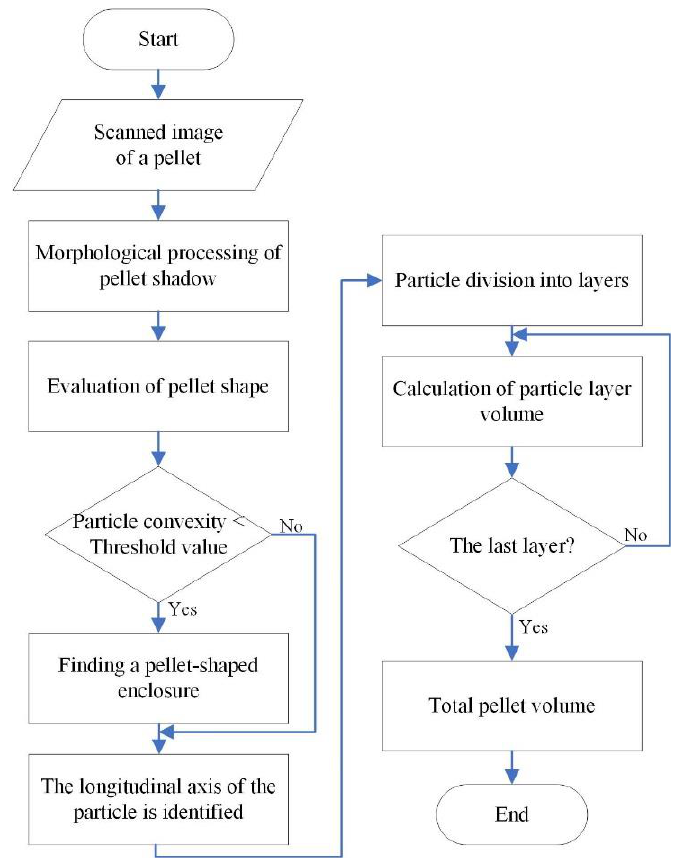
Figure 9. Algorithm for calculation of pellet volume (pellets divided into layers).